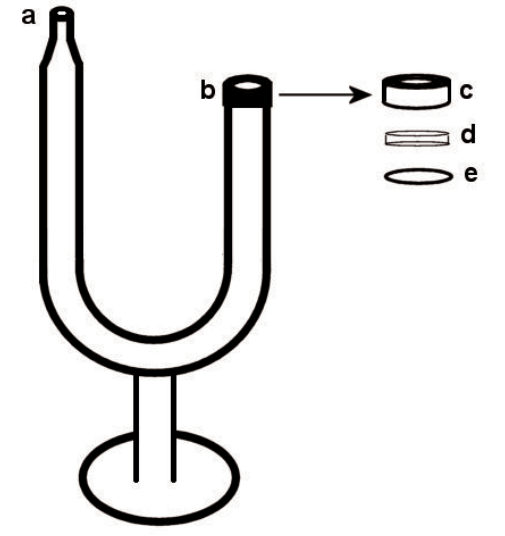
Fig. 1 – Schematic representation of the device to evaluate the water permeability of epicuticular waxes from caatinga and cer- rado species. a = water inlet (diameter 1 mm); b = water vapour outlet (diameter 5 mm); c = plastic cover; d = Whatman paper disc(diameter13mm); e=rubberring. RefertosectionMethods for further